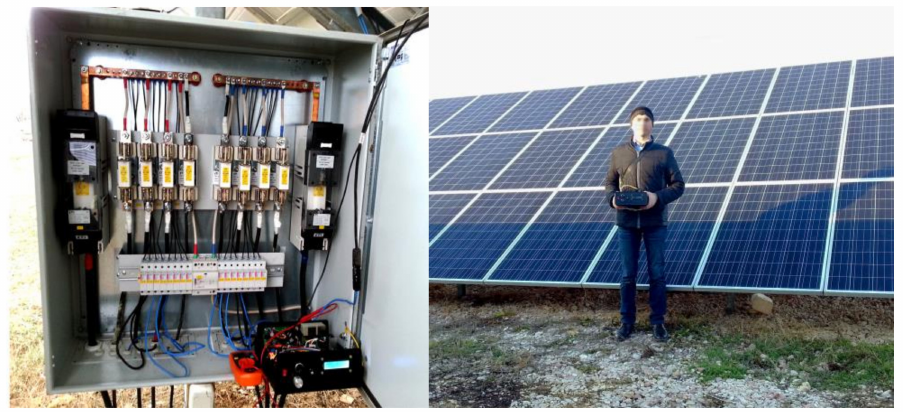
Figure 12. The conducted experimental work on APE prototype estimation on the Sevastopol solar